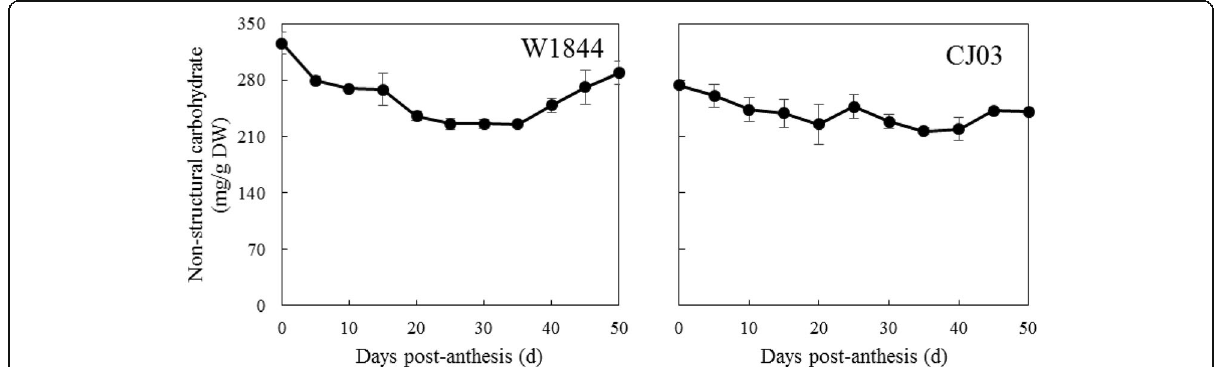
Fig. 6 Changes in nonstructural carbohydrate content in the stem and sheath during the grain filling stage in W1844 and CJ03. Values are means ± SE ( n =